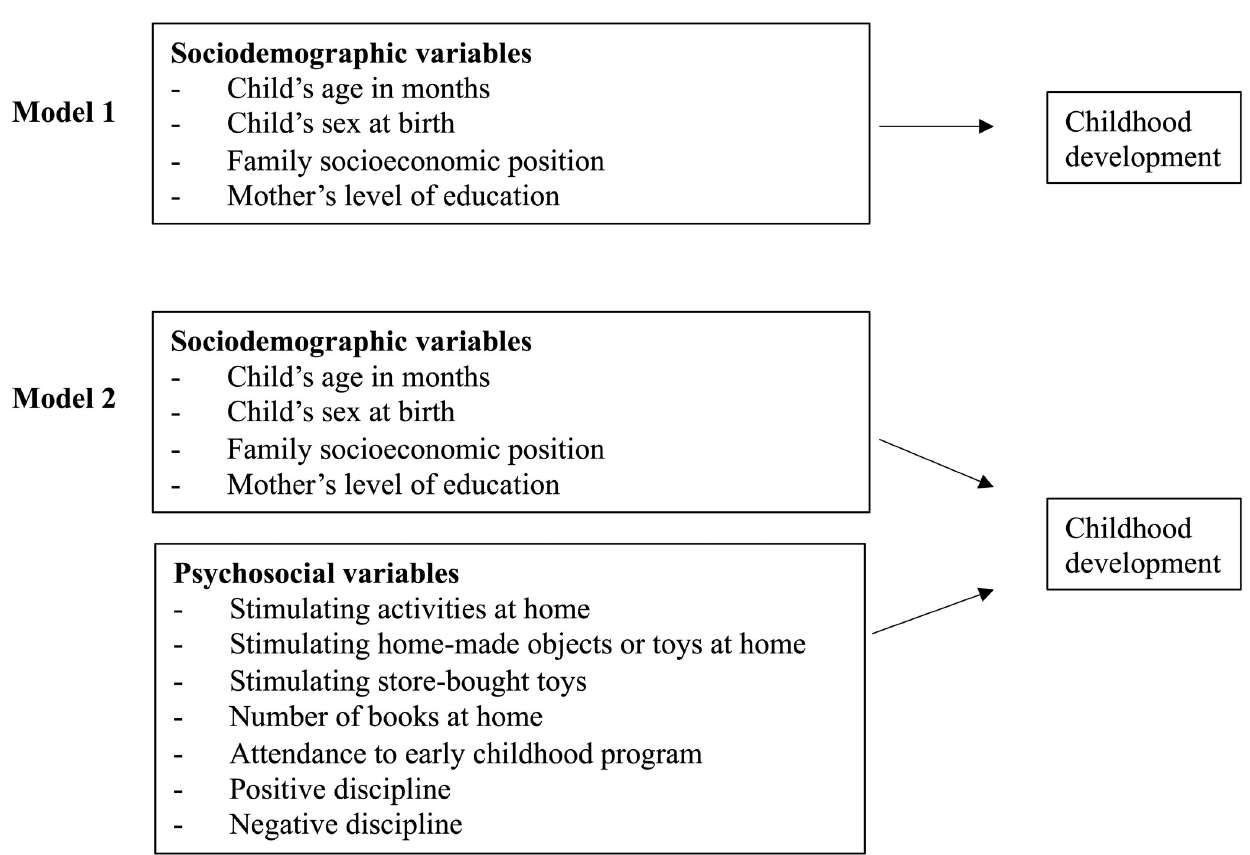
Fig 1. Hierarchical regression models to predict childhood